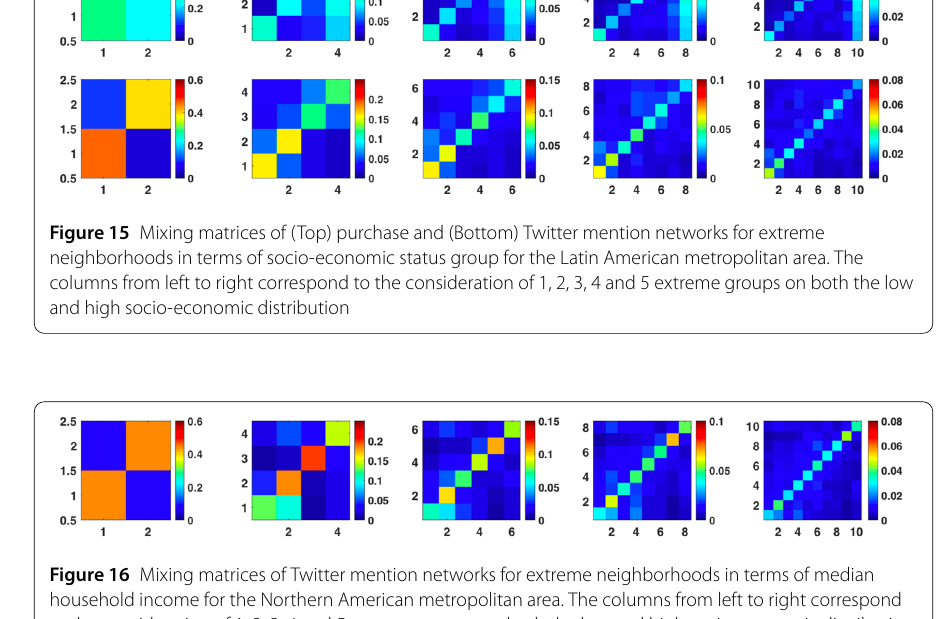
than a set of thresholds. We then compute the assortativity that corresponds to the net- works with the remaining subset of